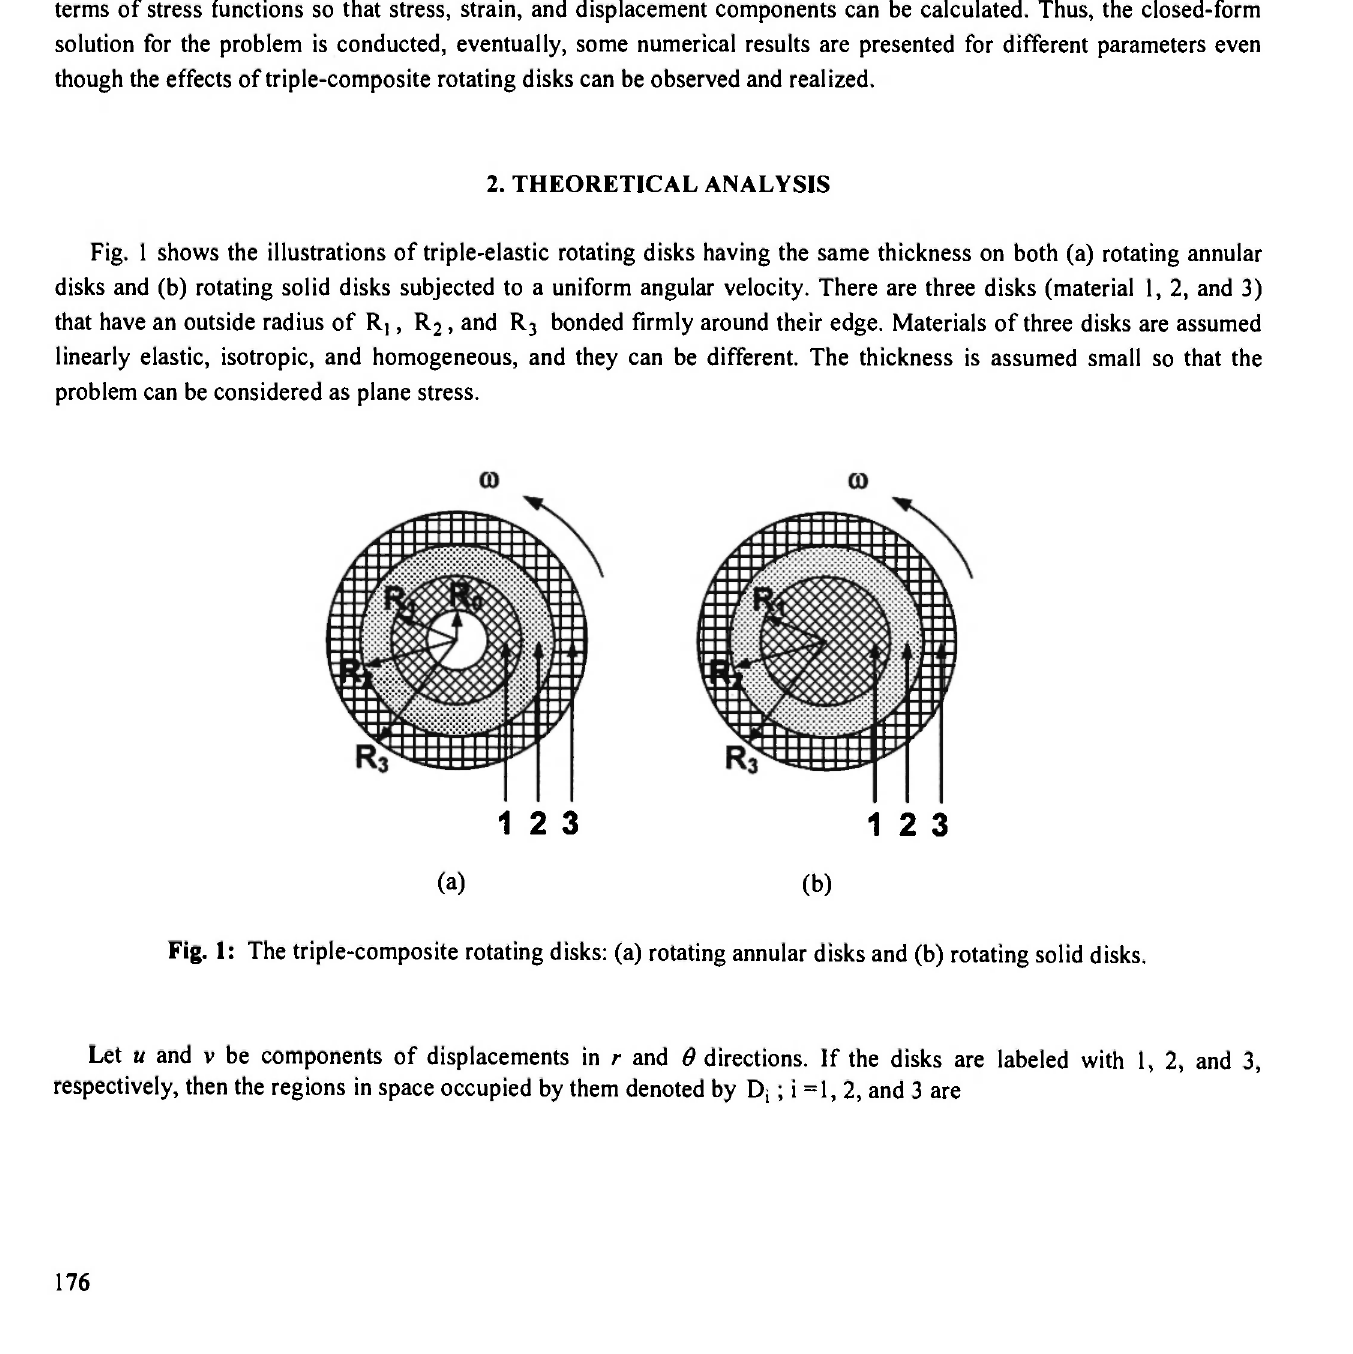
Fig. 1: The triple-composite rotating disks: (a) rotating annular disks and (b) rotating solid